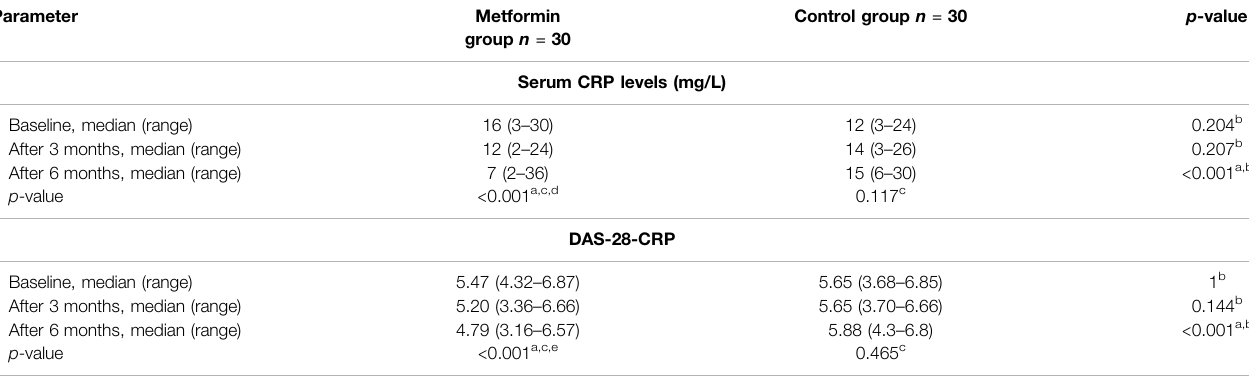
TABLE 2 | Comparison of serum C reactive protein (CRP) levels and disease activity score based on CRP (DAS-28-CRP) between and within the study groups. Parameter